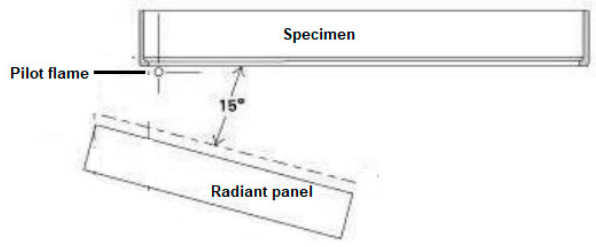
Figure 15. Test configuration scheme.